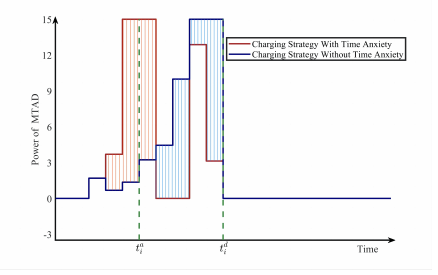
Figure 11. The time anxiety impact of MTAD.